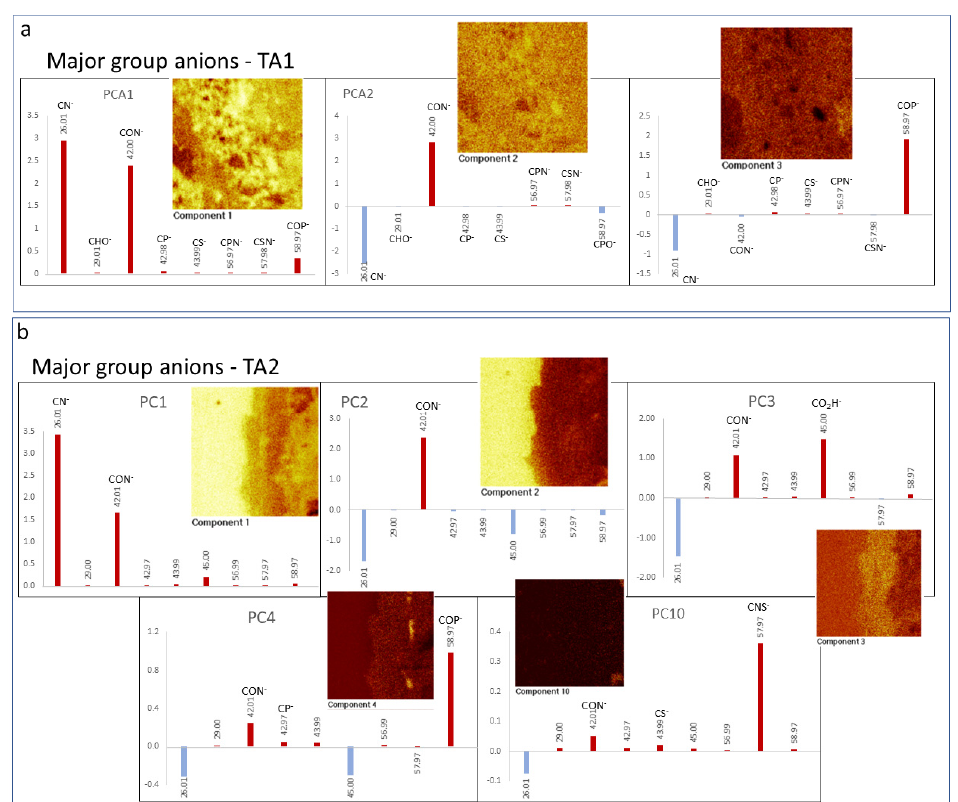
Figure 9. Principal component analysis (PCA) performed for the ToF-SIMS data of the major group ions like CN − , CON − , CP − , COP − , CS − , and CSN − in both TA1 ( a ) and TA2 ( b ) areas. The PCA of TA1 considered 8 masses, while the number of masses were 9 for TA2. The ToF-SIMS images were obtained from a rasterized surface area of a 500 µ m